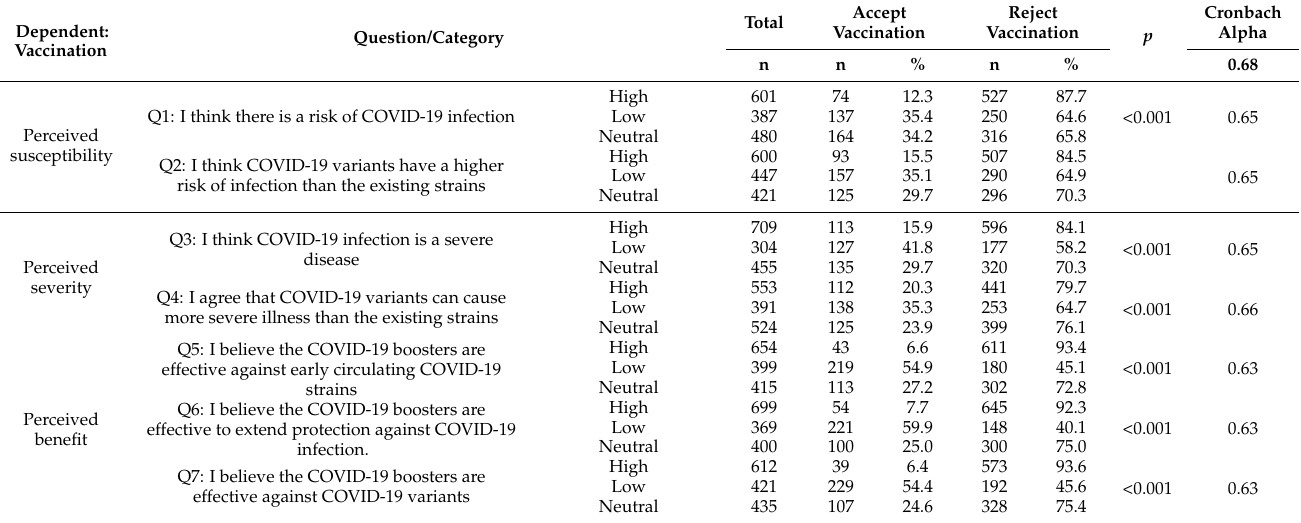
Table 4. Perception of the booster doses based on the health belief